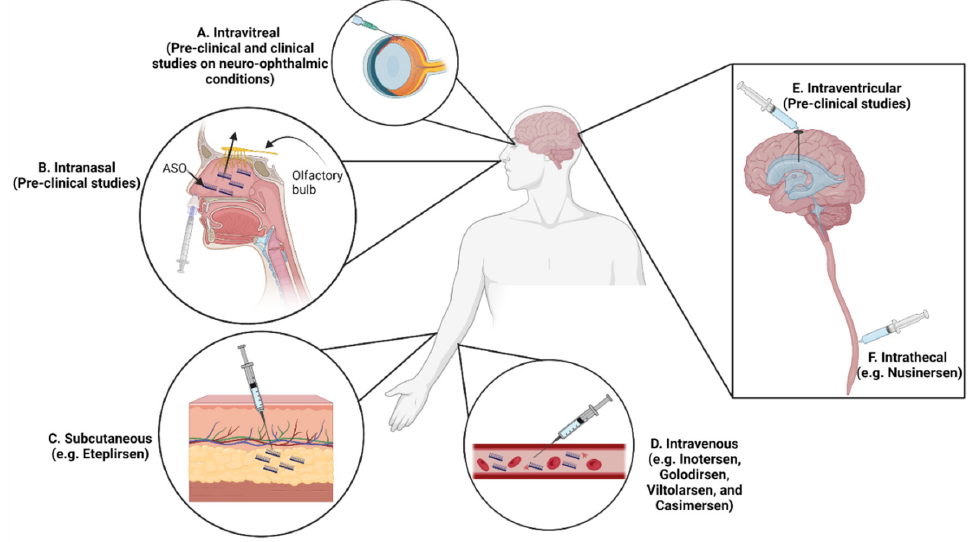
Figure 6. Common routes of antisense oligonucleotide (ASO) administration in neurological disorders include ( A ) intravitreal, ( B ) intranasal, ( C ) subcutaneous, ( D ) intravenous, ( E ) intraventricular,